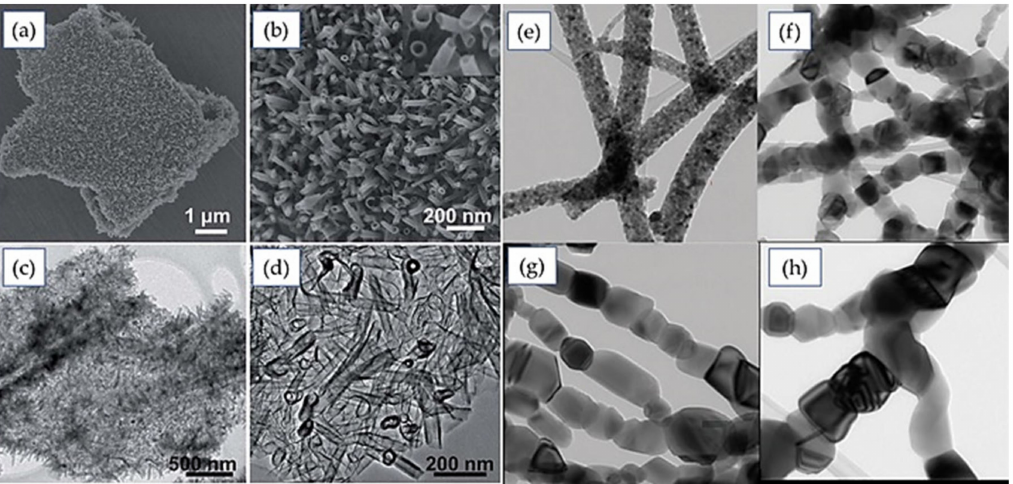
Figure 9. ( a , b ) Scanning electron microscope (SEM) images of Gr–TNTs; inset in ( b ) high- magnification image showing TiO 2 nanotubes on the graphene sheets. ( c , d ) Transmission electron microscope images of the Gr–TNTs. Reprinted with permission from Ref. [70]. Copyright 2014 Royal Society of Chemistry. TEM images of carbon-coated TiO 2 nanofibers ( e – h ) calcined in air